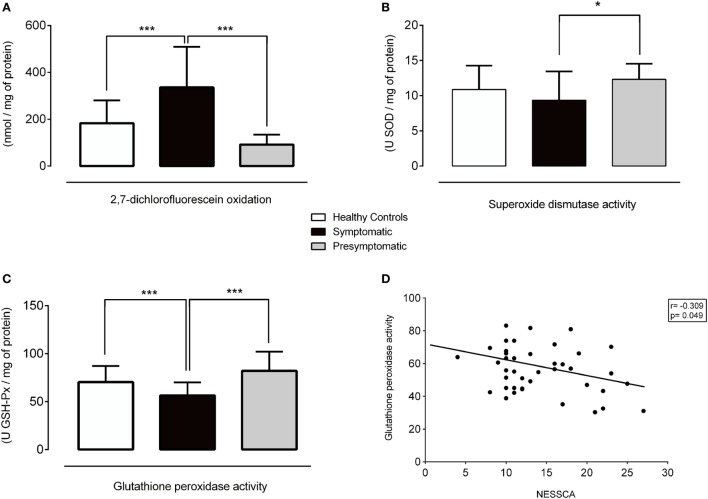
Redox parameters in healthy controls, symptomatic, and presymptomatic SCA3/MJD individuals. (A) ROS levels, (B) SOD activity, (C) GSH-Px activity and (D) Correlation between GSH-Px and NESSCA. Values are presented as the means, and error bars represent standard error; *p < 0.05 and ***p < 0.001. GSH-Px, glutathione peroxidase; NESSCA, Neurological Examination Score for Spinocerebellar Ataxias; ROS, reactive oxygen species; SCA3/MJD, spinocerebellar ataxia type 3/Machado–Joseph disease; SOD, superoxide dismutase.